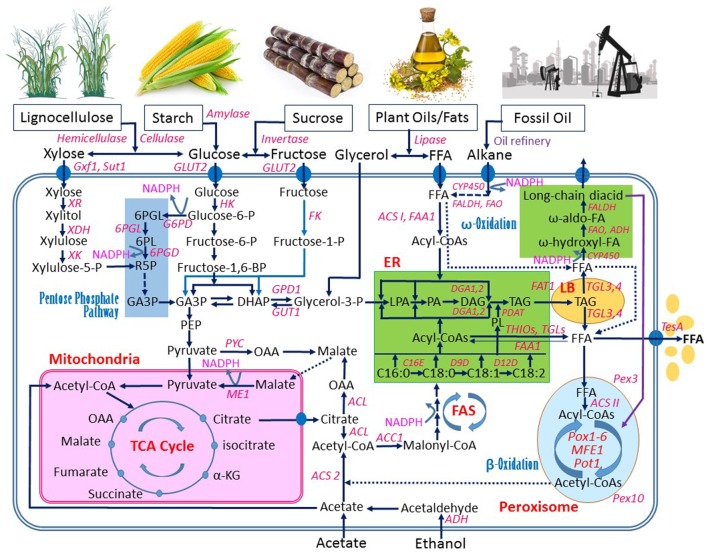
An overview of metabolic pathways in Yarrowia lipolytica for synthesis of fatty acids from various substrates. Abbreviations: ACC1, acetyl-CoA carboxylase 1; ACL, ATP citrate lyase; ACS 2, acetyl-CoA synthetase 2; ACS I and ACS II, fatty acyl-CoA synthetase I and II, respectively; ADH, alcohol dehydrogenase; C16E, C16/C18 elongase; D9D, D-9 desaturase; CYP450, cytochromes P450 enzyme; D12, D-12 desaturase; DAG, diacylglycerol; DGA1 and DGA2, DAG acyltransferase; DHAP, dihydroxyacetone phosphate; ER, endoplasmic reticulum; FAA1, fatty acyl-CoA synthetase; FALDH, fatty aldehyde dehydrogenase; FAO, fatty alcohol oxidase; FAS, fatty acid synthase; FAT1, long-chain fatty acid transporter 1; FFAs, free fatty acids; FK, fructose-kinase; G6PD, glucose-6-phosphate dehydrogenase; GA3P, glyceraldehyde-3-phosphate; GLUT2, glucose transporter 2; GPD1, glycerol-3-phosphate dehydrogenase; GUT1 and GUT2, glycerol kinase; GXf1, glucose/xylose facilitator; HK, hexokinase; α-KG, α-ketoglutarate; LB, lipid bodies; LPA, lysophosphatidic acid; ME1, malic enzyme 1; OAA, oxaloacetate; MFE1, peroxisomal multifunctional enzyme 1; PA, phosphatidic acid; PDAT, PL and DAG acyltransferase; PEP, phosphoenolpyruvate; Pex3 and Pex10, peroxisome biogenesis factor 3 and 10; 6PGD, 6-phosphogluconate dehydrogenase; 6PGL enzyme, 6-phosphogluconolactonase; 6PGL intermediate, 6-phosphogluconolactone; PL, phospholipid; Pot1, peroxisomal 3-oxoacyl-CoA thiolase; Pox1~Pox6, acyl-CoA oxidases 1~6; PYC, pyruvate carboxylase; SUT1, sucrose transporter; TAG, triacylglycerol; TCA, tricarboxylic acid cycle; TesA, thioesterase I; TGL3 and TGL4, TAG lipase 3 and 4; THIOs, Acyl-CoA thioesterases; XDH, xylitol dehydrogenase; XK, xylulose kinase; XR, xylose reductase. Filled ovals: transport enzymes. Dash lines: multistep metabolic route. Thin line with arrows: metabolic route with a weaker activity.